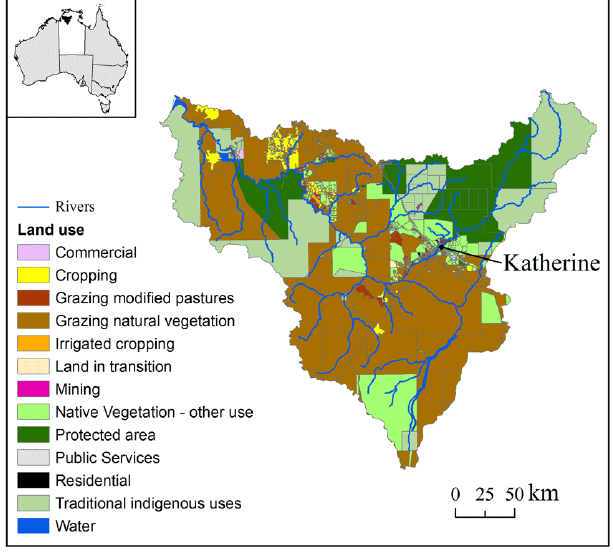
Fig. 1 . Daly catchment property boundaries and land use as defined by ABARES land-use mapping. Inset shows the Northern Territory (white) and the Daly catchment